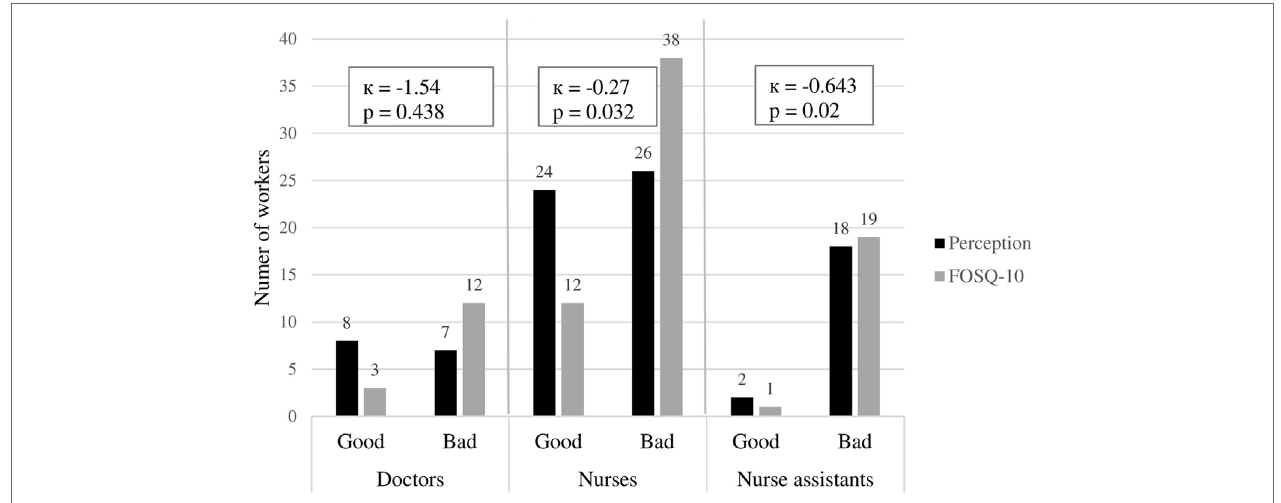
FigUre 4 | Concordance between perceived sleep quality and Functional Outcomes of Sleep Questionnaire (FOSQ)-10 questionnaire according to each professional category. The best concordance between perceived sleep quality and FOSQ-10 results was for the nurse assistants group.